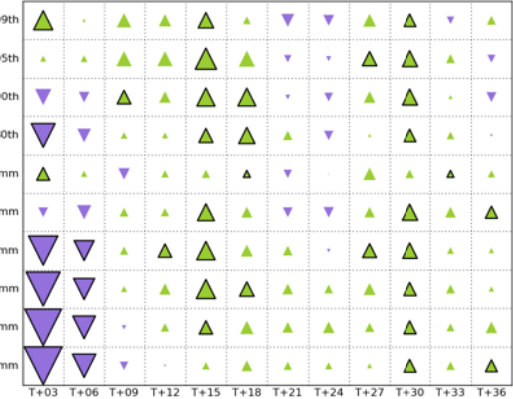
Figure 7. Hinton diagrams showing the differences in fractions skill scores (max = 0.073) for June 2019 for ( a ) EXPT_uv—CTRL, ( b ) EXPT_uvT—CTRL, and ( c ) EXPT_uvTQ—CTRL. Here, green upward-pointing triangles indicate higher skill for experiments, and purple downward-pointing triangles indicate otherwise. A range of absolute and relative rainfall thresholds (ordinate) for a grid box size 10 km × 10 km are used to summarize the impact at increasing forecast lengths along the abscissa.